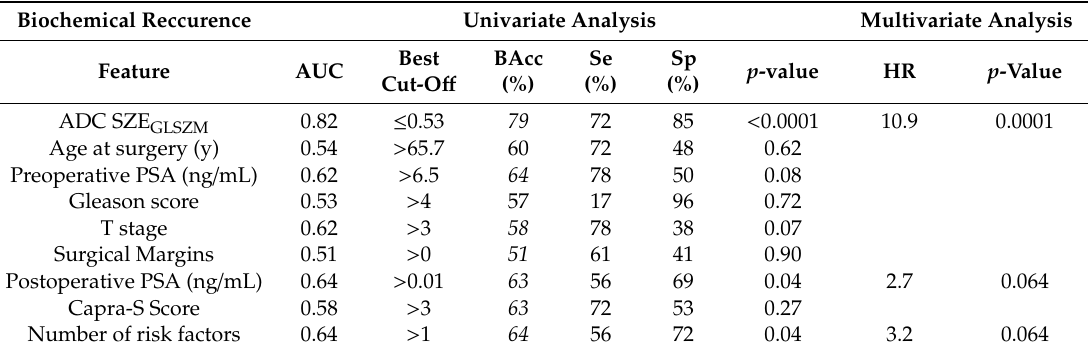
Table 2. Correlation between clinical / radiomics features and biochemical recurrence (training). Biochemical